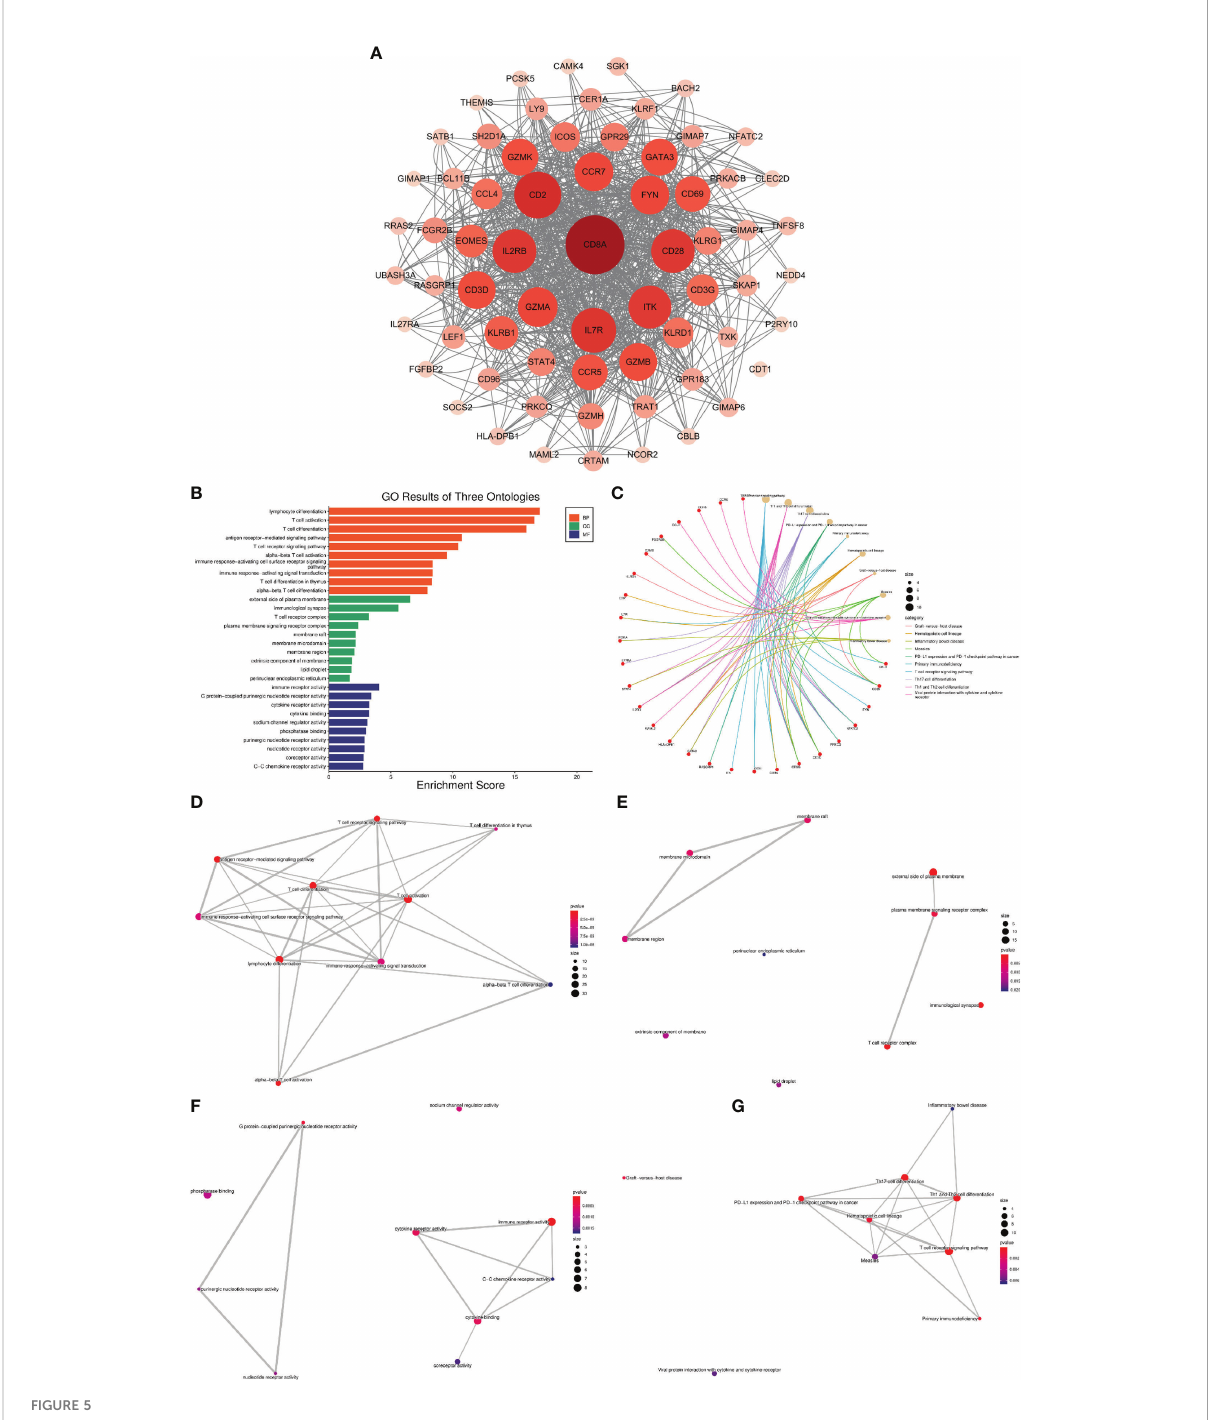
FIGURE 5 Network analysis of VRDEGs (A) The core gene network after the intersection of genes was screened by the MCODE plugin. The darker the color and the larger the circle, the more nodes the gene plays. (B) GO enrichment analysis results, orange is BP, green is CC, blue is MF, the abscissa is the enrichment score, and the ordinate is the pathway name. (C) KEGG enrichment analysis results. The red is the gene, and the yellow is the pathway. The larger the circle is, the more genes are enriched in the pathway. Different colors represent different enrichment results. (D – G) . Network plot of KEGG and GO enrichment analysis. Each link represents a commonly enriched gene between pathways, and the thicker the connecting line, the greater the number of common genes. The more enriched genes, the bigger the dots, and the smaller the P value, the redder the